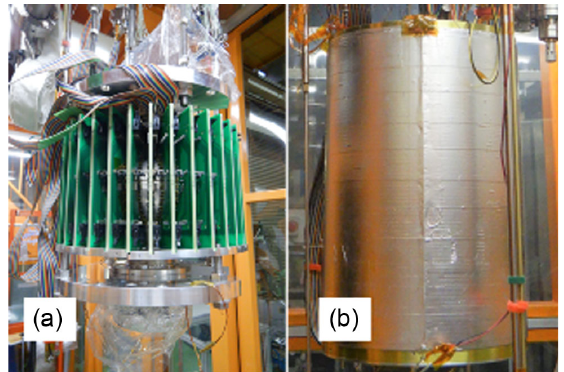
FIG. 3. Photo of the setup of the mapping boards. (a) 36 boards were mounted around the cavity along the circumferential direction. (b) A solenoid coil that controls the ambient z -axis magnetic field covered the mapping boards and